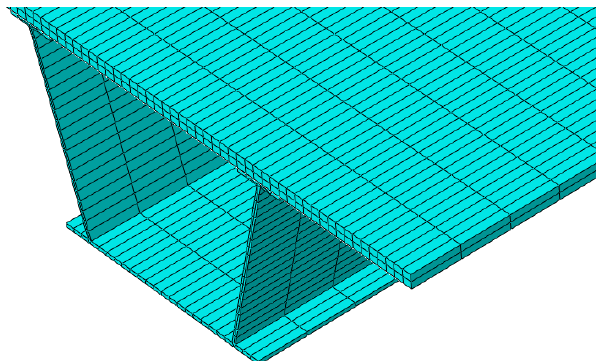
Figure 8. Detail of the typical mesh of the